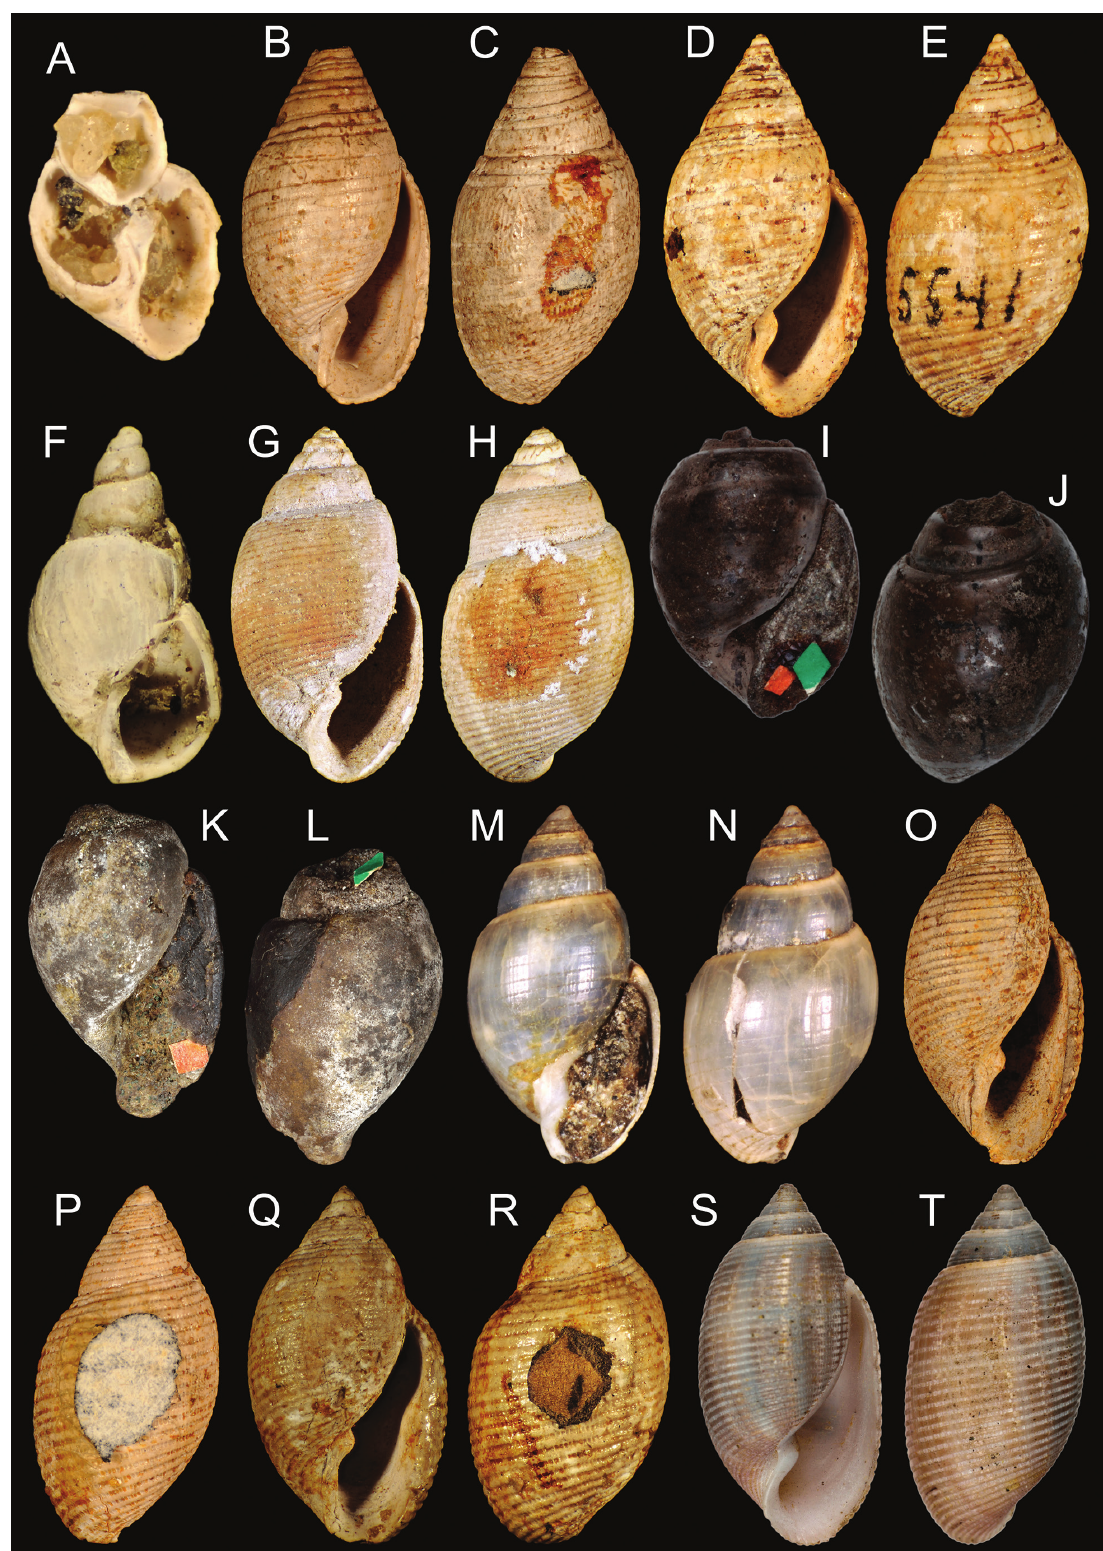
Figure 2. Types. A. Holotype of Acteon glans , H 1.9 mm, ANSP IP1517. B–C. Syntype of Acteon idoneus , H 11.1 mm, ANSP IP30547. D–E. Lectotype of Acteon lineatus , H 8.6 mm, ANSP IP5541. F. Holotype of Acteon nitens , H 4.0 mm, ANSP IP1516. G–H. Syntype of Acteon novellus , H 12.0 mm, ANSP IP1600. I–L. Syntype of Acteon ovoidea , H 23 mm, ANSP IP56167. 32–33. Same, H 21.0 mm, ANSP IP56166; also, holotype of A. subovoides . M–N. Lectotype of Acteon politus , H 8.2 mm, ANSP IP4266. O–P. Syntype of Acteon pomilius , H 10.1 mm, ANSP IP30546. Q–R. Syntype of Acteon punctatus , H 8.8 mm, ANSP IP5537. S–T. Holotype of Acteon subtornatilis , H 18.1 mm, ANSP